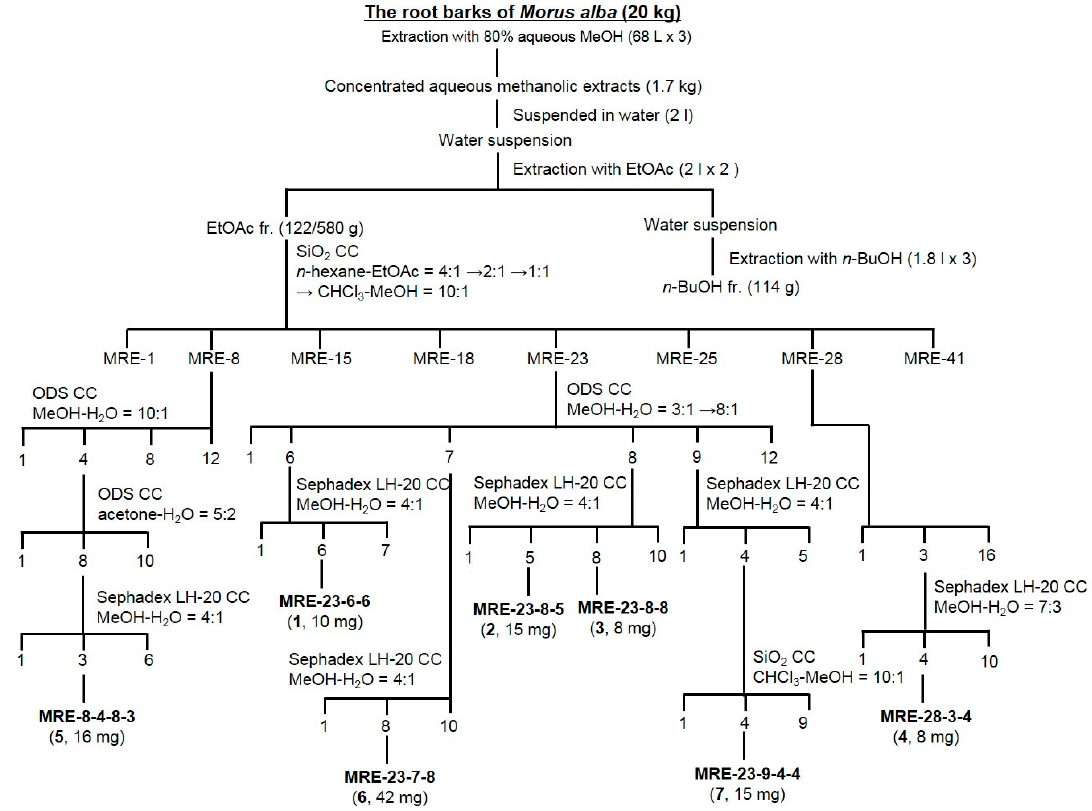
Figure 1. Extraction, fractionation, and isolation scheme of isoprenylated flavonoids from the root bark of Morus alba . SiO 2 : silica gel; CC: column chromatography; ODS: octadecyl silica gel; MRE: EtOAc fraction of Morus alba root bark.